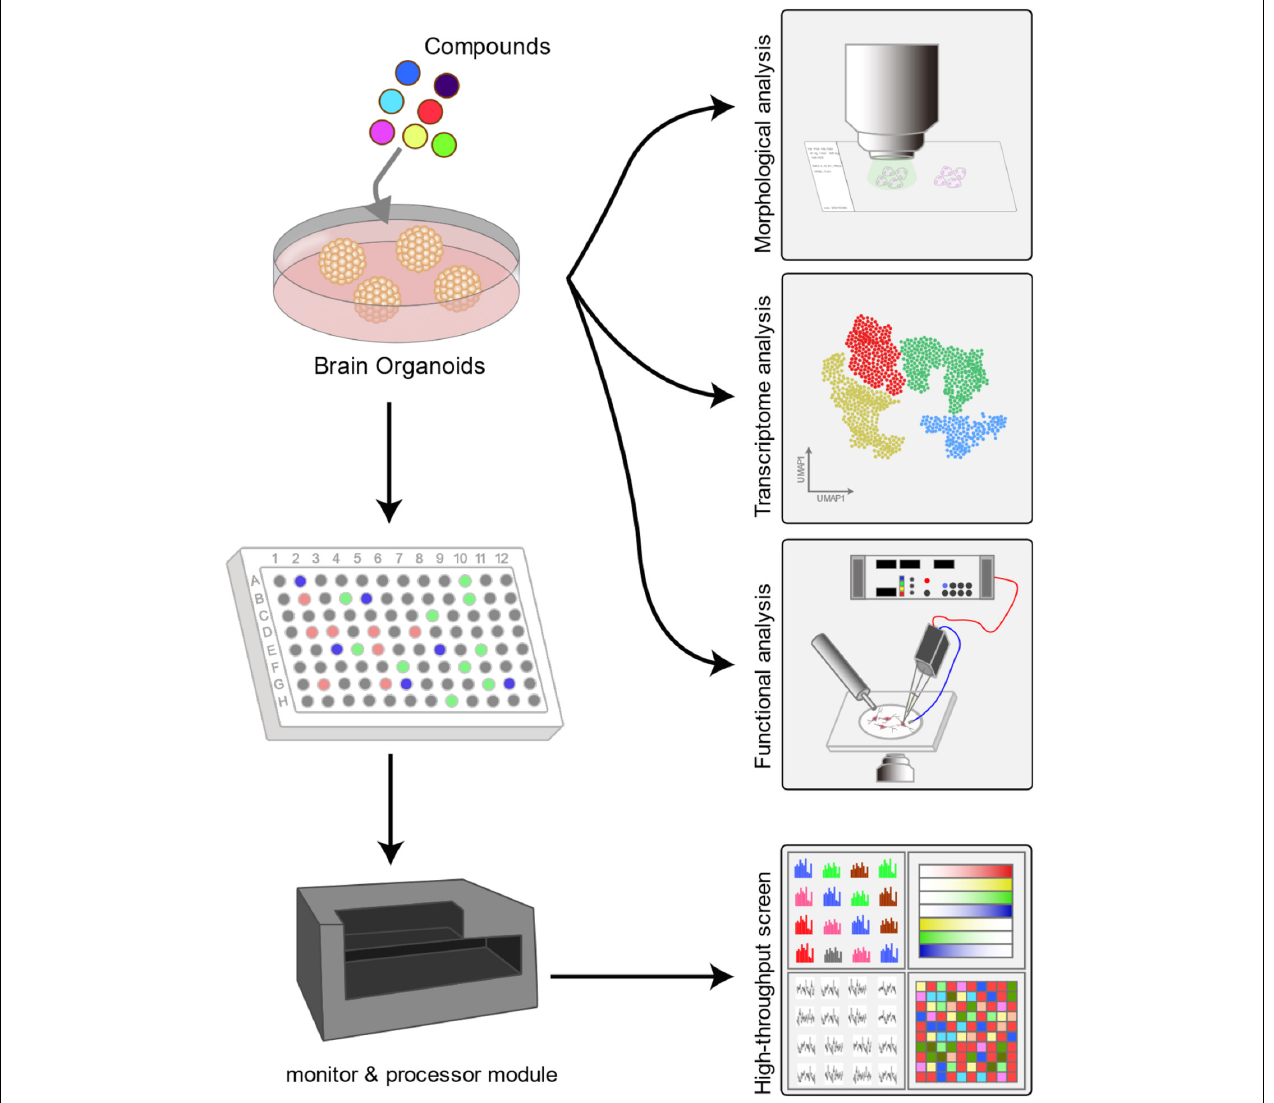
FIGURE 3 | Application of brain organoids in neurotoxicity assessment. Typically, neurotoxicity to brain organoids is measured by morphological analysis, such as bright field microscopy and immunohistochemical analysis. By combining transcriptomics, metabolomics and proteomics analysis, researchers could identify the certain mechanisms underlying neurotoxicity. Additionally, the functional changes in neurons can be clarified by electrophysiology and calcium imaging analysis. Moreover, in high-throughput neurotoxicity studies, the readouts are usually collected by miniaturized monitors such as MEAs and microcameras and then processed by a machine learning algorithm processor. The combination of machine learning algorithms enables comprehensive and reliable high-throughput neurotoxicity assessment.